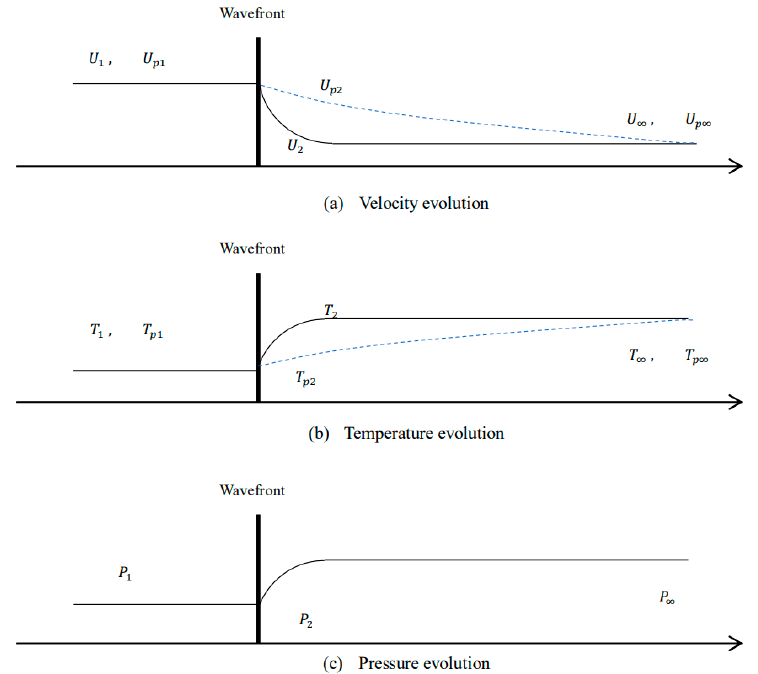
Figure 4. Variation of the temperature, pressure, and velocity of the gas and solid phases during the interaction process. ( a ); Velocity evolution ( b ); Temperature evolution ( c ) Pressure evolution. The